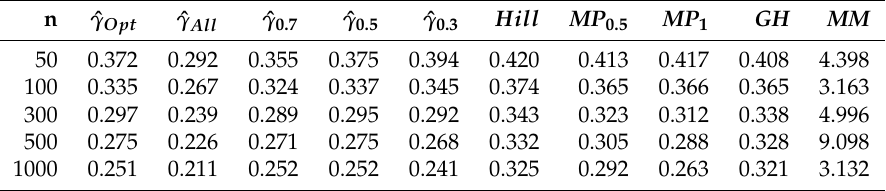
Table 7. RMSE of the estimators for the Stable(1.1) distribution; 1000 Montecarlo replications.